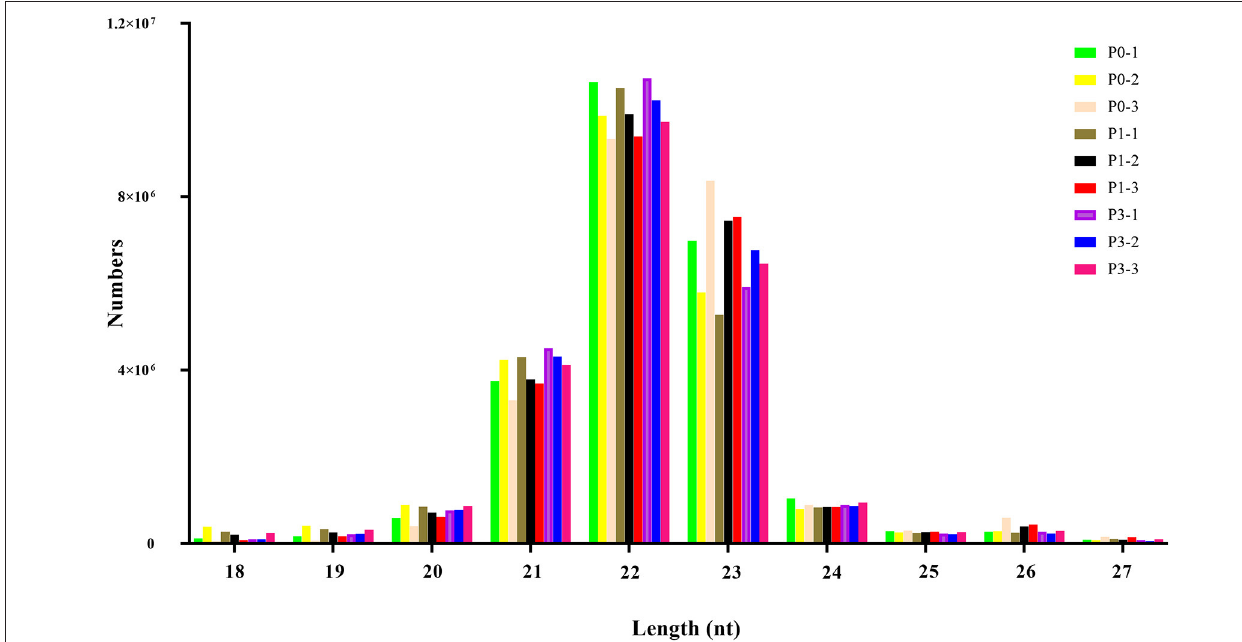
FIGURE 1 | The distribution of small RNAs relative to length in the three groups of New Zealand Rabbits lung.